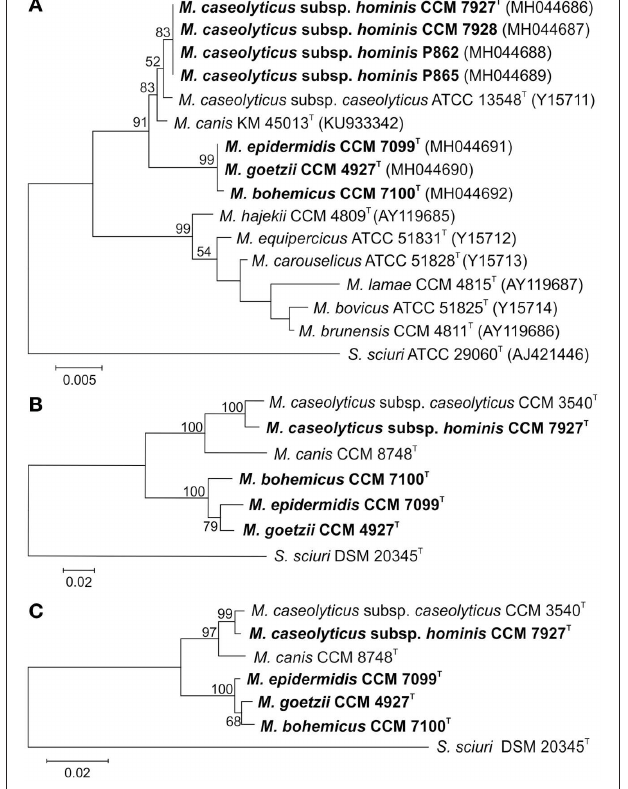
FIGURE 1 | Phylogenetic trees showing the position of human macrococci within the genus Macrococcus based on (A) 16S rRNA gene sequence; (B) concatenated housekeeping genes hsp60 , rpoB , dnaJ , tuf , gap , and sodA ; and (C) concatenated housekeeping gene protein products. The sections of the gene sequences and their protein products correspond to the following gene coordinates of Staphylococcus aureus subsp. aureus NCTC 8325 (GenBank accession number NC_007795): 14 to 1608 for hsp60, 82 to 3552 for rpoB , 1 to 1116 for dnaJ , 7 to 1200 for tuf , 15 to 1026 for gap , and 2 to 599 for the sod A gene. The evolutionary history was inferred using the Maximum Likelihood method based on the Tamura-Nei model. The tree with the highest log likelihood is shown. Bootstrap probability values (percentages of 1,000 tree replications) greater than 50% are indicated at branch points. Bar indicates number of substitutions per nucleotide position. Staphylococcus sciuri type strain was used as an